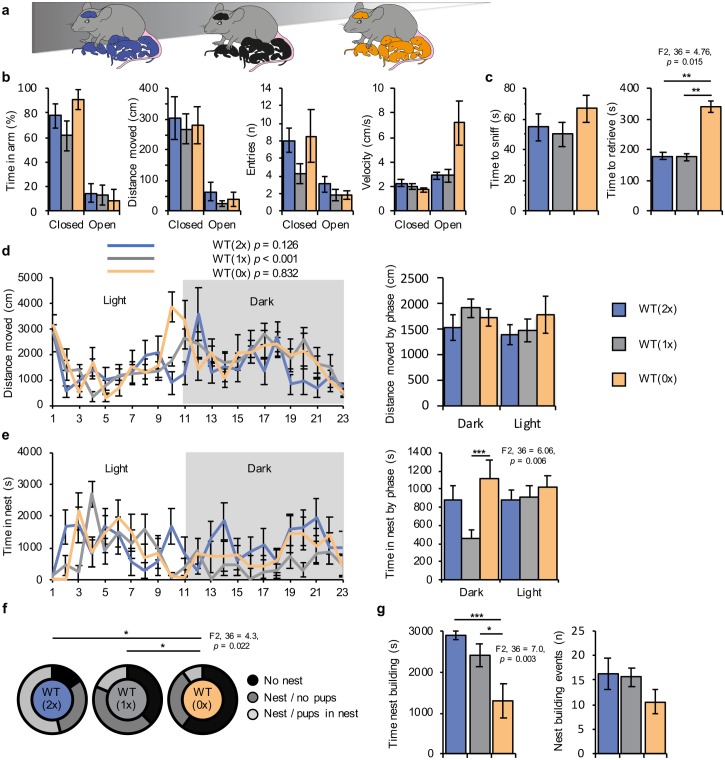
Classic tests of maternal behaviour reveal altered behaviour in WT dams exposed to different doses of offspring Phlda2.(A) Schematic of behavioural paradigm. WT(0x) n = 13, WT(1x) n = 14, and WT(2x) n = 11 experimental dams carrying and caring for pups with 0, 1, or 2 active copies of Phlda2. (B) EPM performed on P2. Percentage of time spent in open and closed arms, number of entries in the open and closed arms, distance moved, and mean velocity measured over 5 minutes. (C) Pup retrieval task on P3. Time taken to sniff and retrieve the first pup measured over 20 minutes. (D) Activity tracking during a 23-hour period after pup-retrieval task. Distance travelled per hour during each phase and total distance travelled during the light phase and dark phases. (E) Time spent on the nest over 23 hours and total time spent in nest during the light phase and dark phase. (F) Nest building task on P4. Dams scored on their ability to build a nest during a 1-hour test (no nest built; nest built/no pups moved into nest; nest built/pups moved into nest). Of the dams, 7/11 WT(2x), 3/14 WT(1x), and 1/13 WT(0x) built a nest and placed at least 1 pup inside within the time limit. (G) Time spent building nest (left panel) and number of nest building events (right panel). Numerical data can be found at https://osf.io/543jg/ “RAW NUMERICAL DATA.xlsx”, Sheets labelled EPM, Pup_Retrieval_Nest_Building, Ethovision_23hr. Data shown as mean ± SEM. Significance determined using one-way ANOVA Dunnet post hoc test. Statistical significance: *p < 0.05, **p < 0.01, and ***p < 0.005. EPM, elevated plus maze; P, postnatal day; Phlda2, pleckstrin homology-like domain family A member 2; WT, wild-type; WT(0x), WT dams carrying and caring for all Phlda2−/+ embryos (maternal inheritance of targeted allele, Phlda2 loss of function); WT(1x), WT dams carrying and caring for all WT embryos; WT(2x), WT dams carrying >60% Phlda2+/+BACx1 embryos generated by crossing Phlda2+/+BACx1 dams and Phlda2+/+BACx1 studs.